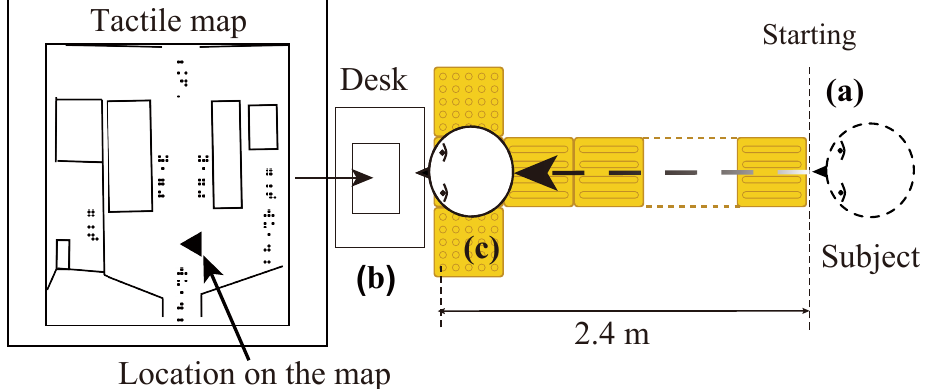
Figure 8. Experiment overview: ( a ) Subject walks from the beginning of the braille block. ( b ) The tactile map on the desk is read. ( c ) Subject moves in the direction of the target